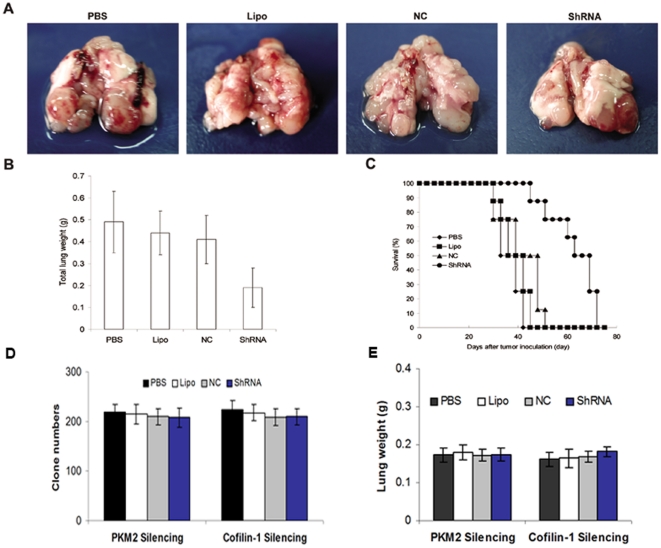
Cofilin-1 suppression retarded pulmonary metastatic tumor growth and enhanced mice survival.(A). Representative photos of metastatic-tumor-bearing lung tissues (B). Lung weight changes of mice treated with cofilin-1-ShRNA (P<0.05). (C). Kaplan-Meier survival curves of tumor-bearing mice (Log-rank test, P<0.01). (D). Treatment with PKM2 or cofilin-1-ShRNA did not affect the growth of normal human bronchial epithelial cells BEAS-2B by clonogenic formation assays (P>0.05). (E). In vivo studies showed that the lung weight of PKM2 or cofilin-1-ShRNA treated group (normal mice, i.e. not bearing tumor) did not have significant changes compared with the control groups (P>0.05).